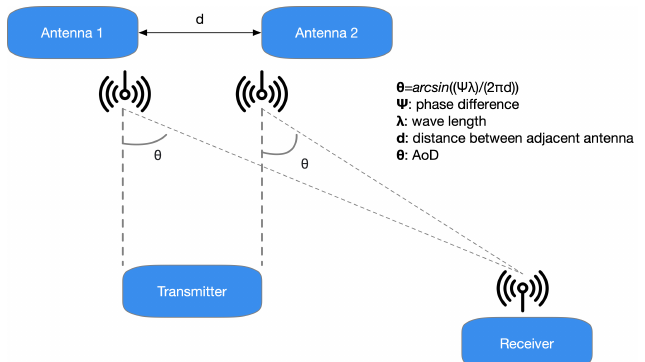
Figure 4. In the AoD technique, when every packet broadcasted by the antennas’ array comes at the antenna of the receiver, a phase-shifted regarding the preceding signal is appraised owing to the distinct length covered from the transmitter.